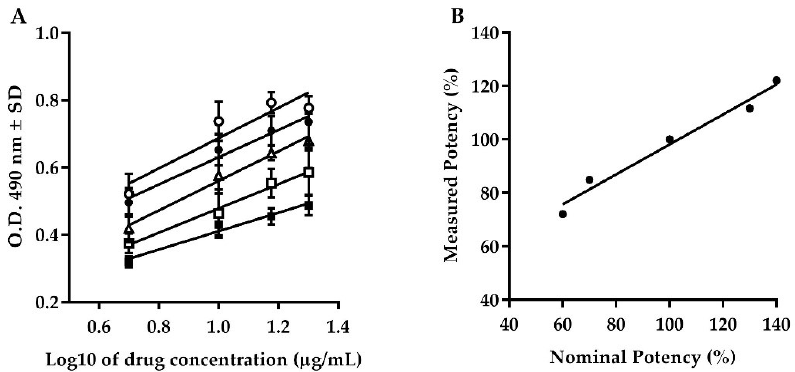
Figure 2. Accuracy. ( A ) Behavior of dilutional linearity at dilution levels of 60% (black squares), 70% (white squares), 100% (white triangles), 130% (black circles), and 140% (white circles) of Transferon ® . ( B ) Relationship between nominal and measured potency at dilution levels from 60 to 140% ( r 2 = 0.97). O.D.: Optical Density; SD: Standard Deviation